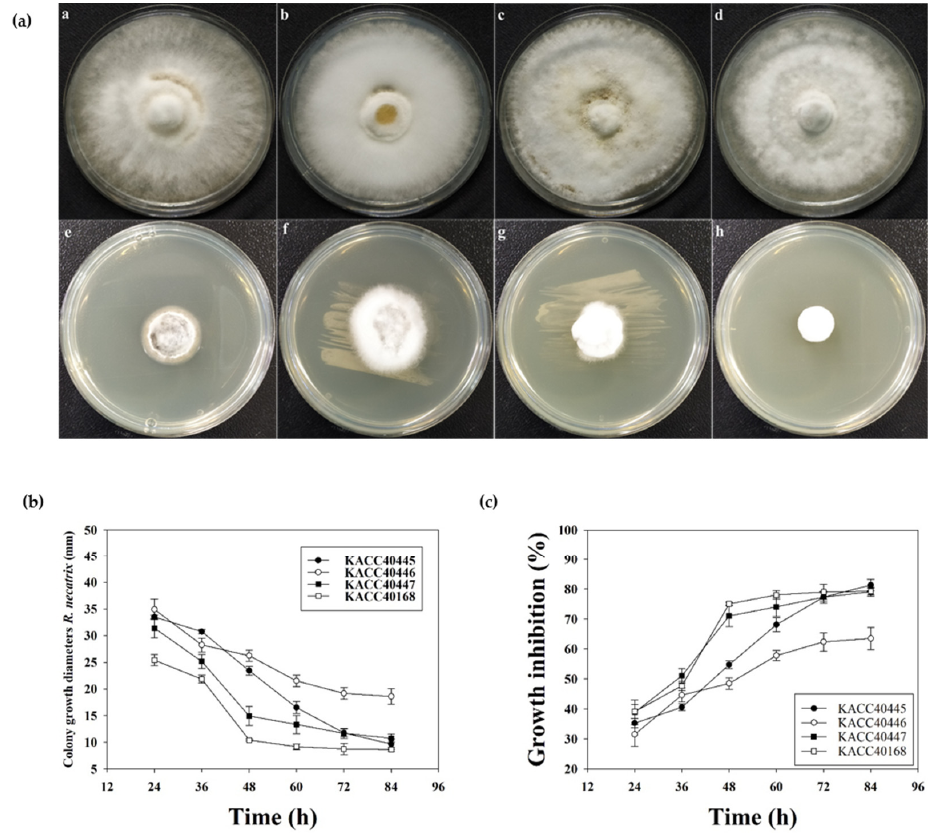
Figure 3. Effect of the cell-free supernatant (CFS) of RDA1 on the mycelial growth of different strains of R. necatrix. ( a ) Plates a, b, c, and d are the controls for R. necatrix strains KACC 40445, 40446, 40447, and 40168, respectively. Plates e, f, g, and h contain CFS collected at 90 h. ( b ) Effect of the CFS of RDA1 on colony growth diameter at various incubation time points (24, 36, 48, 60, 72, and 90 h). ( c ) Effect of the CFS of RDA1 on the growth inhibition percentage of R. necatrix at various incubation time points (24, 36, 48, 60, 72, and 90 h). Vertical bars indicate ± standard deviation ( n = 9). 2.4. Antifungal Activity of Bacterial Volatile Compounds (VOCs) against R. necatrix